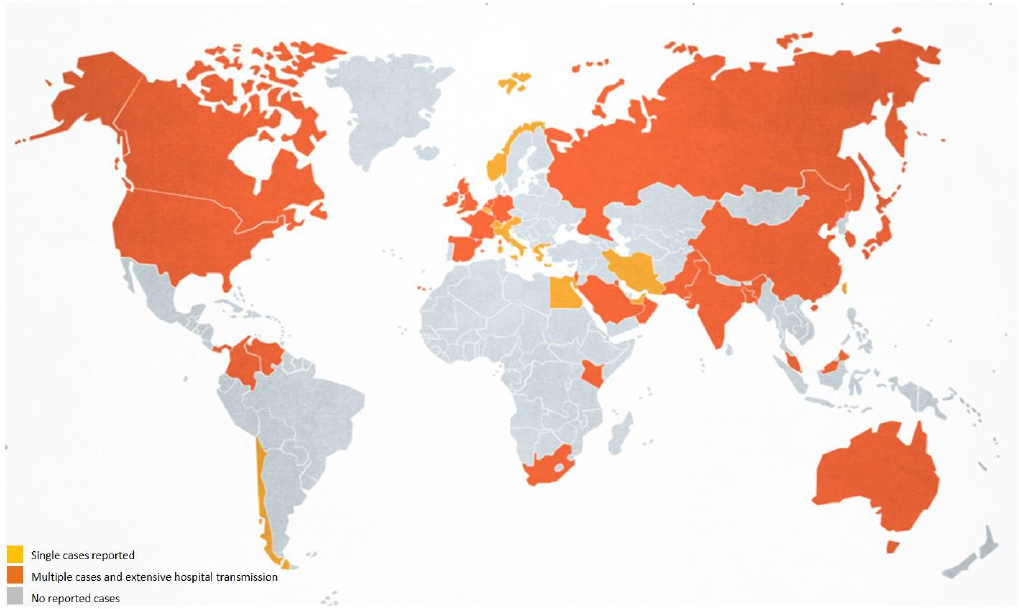
Figure 1. Global epidemiology of Candida auris for November 2019 (image adapted from CDC [19]). Single cases were reported from Austria, Belgium, Chile, Italy, Greece, Egypt, Iran, Norway,